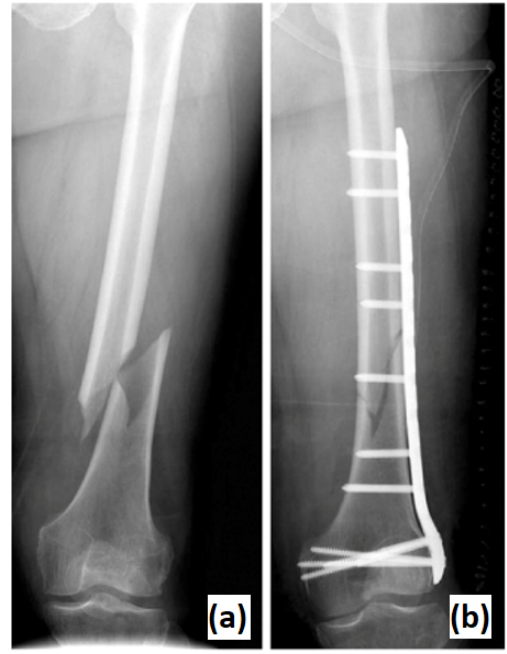
Figure 1. Fracture of a patient’s femur (a) . Result of reduction surgery and implant installation (b)